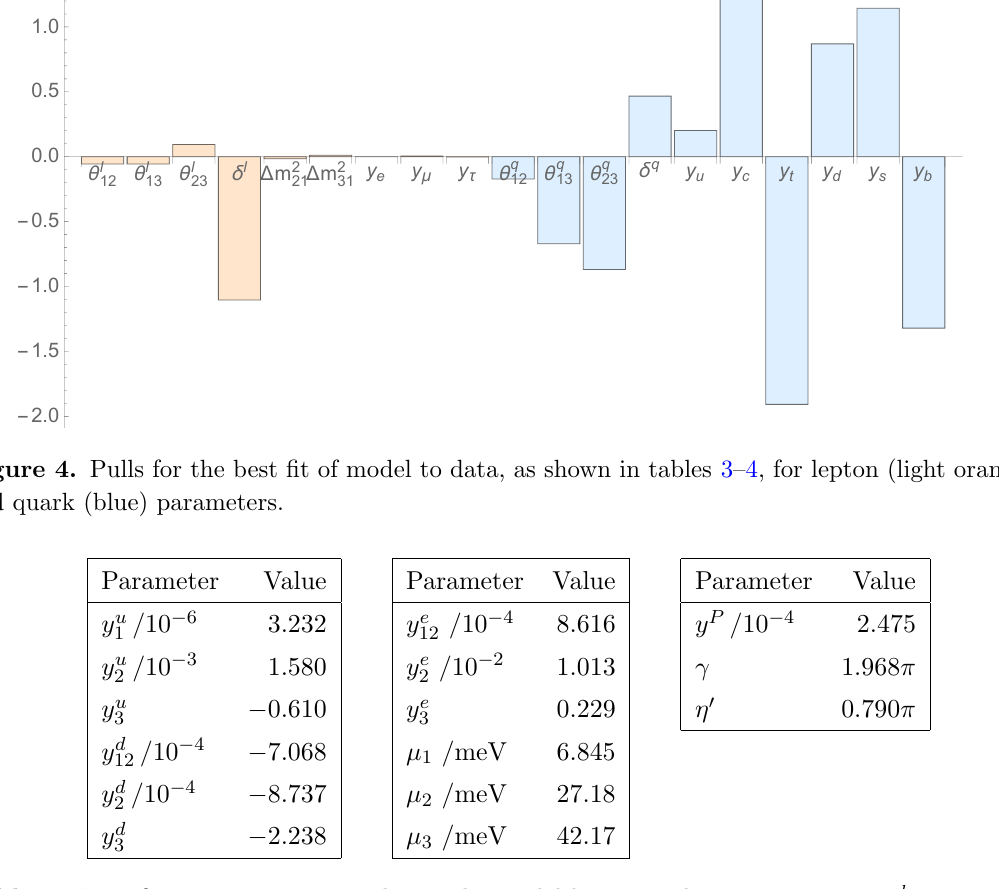
, y d , y e , (cid:22) i and i i i